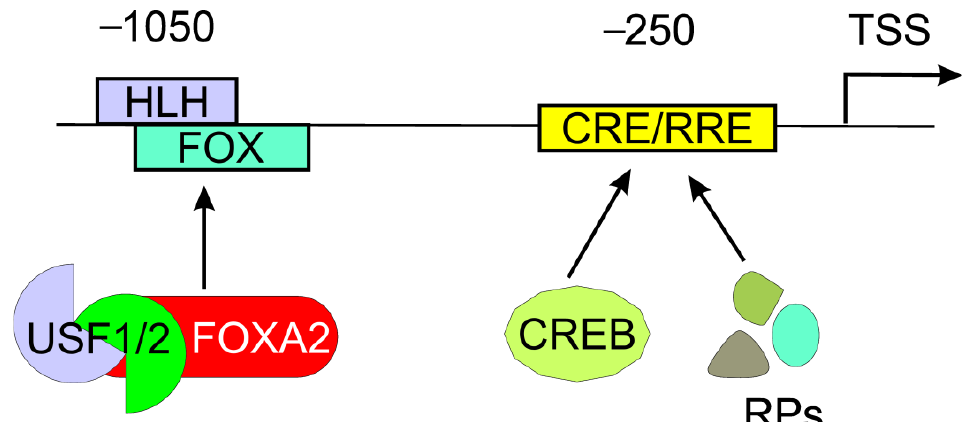
Figure 1. The main regulatory element in the promoter of calcitonin gene-related polypeptide alpha ( CALCA ) is an 18-bp enhancer, which is a part of a distal cell-specific complex helix–loop–helix (HLH) enhancer. The HLH motif of the 18-bp enhancer overlaps with a forkhead (FOX) motif and is targeted by heterotrimer upstream stimulatory factor (USF)-1 and -2 and the cell-specific forkhead box A2 protein (FOXA2). The promoter also contains a proximal cAMP-responsive element (CRE) and a Ras responsive element (RRE) targeted by the cyclic adenosine monophosphate (cAMP) response element-binding protein (CREB) and related proteins (RPs). Approximate positions of these two elements, upstream of the transcription start site (TSS), are indicated. The CALCA promoter contains both cell-specific and non-cell-specific elements as well as CpG dinucleotides contributing to functional CpG islands not presented here.